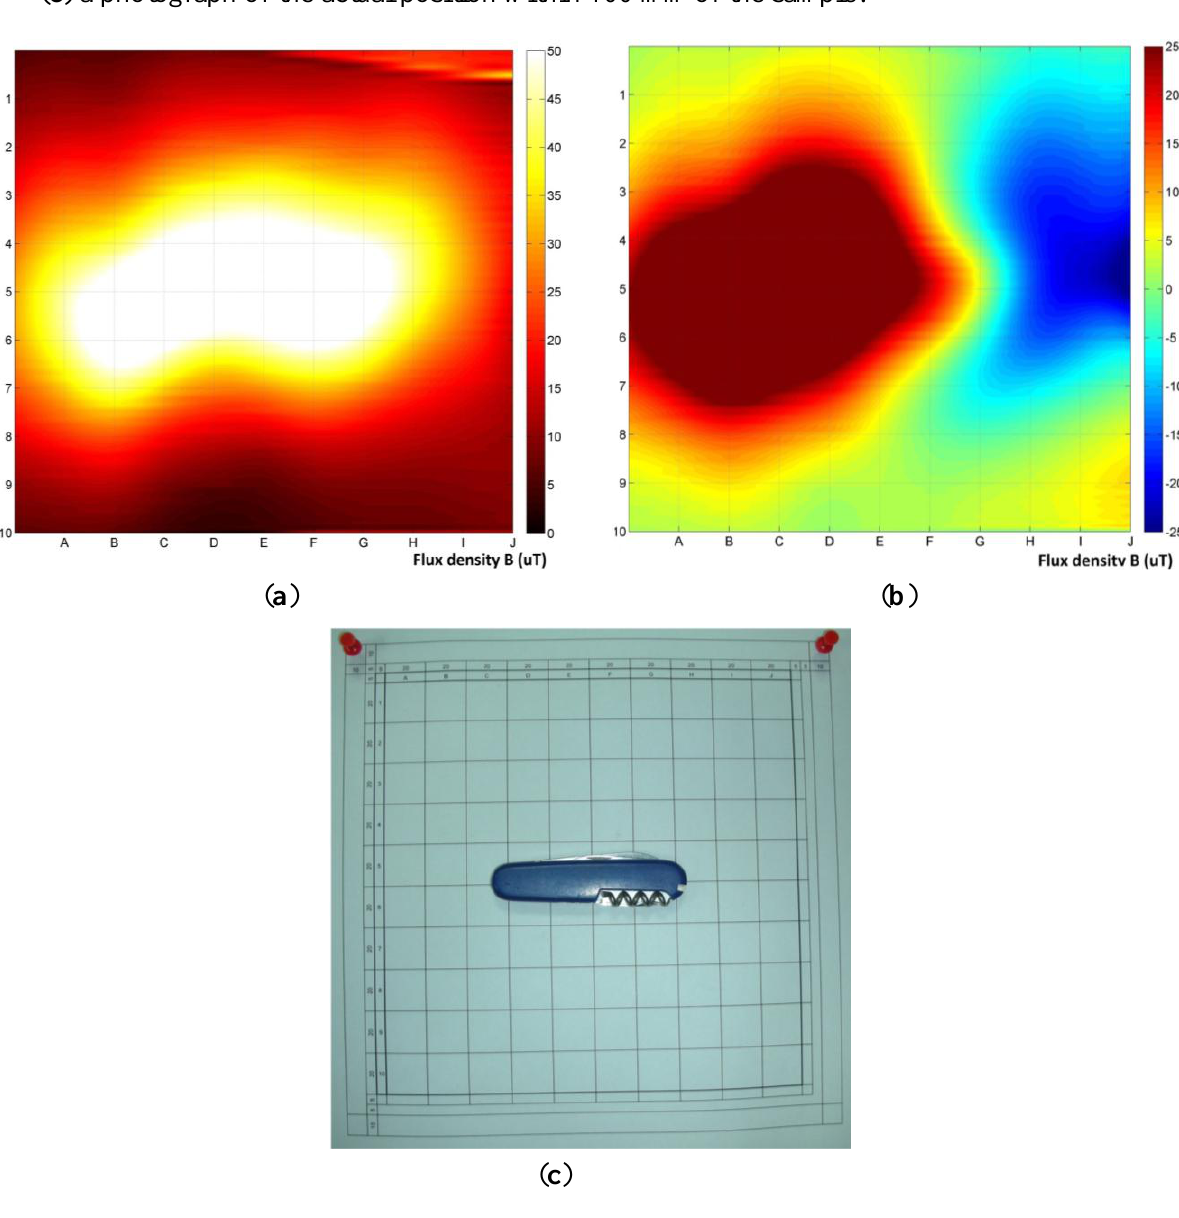
Figure 7. Measurement of the position of dangerous object (Swiss army knife): ( a ) biplane differential measurement; ( b ) gradient measurement without background separation; ( c ) a photograph of the actual position within 100 mm of the